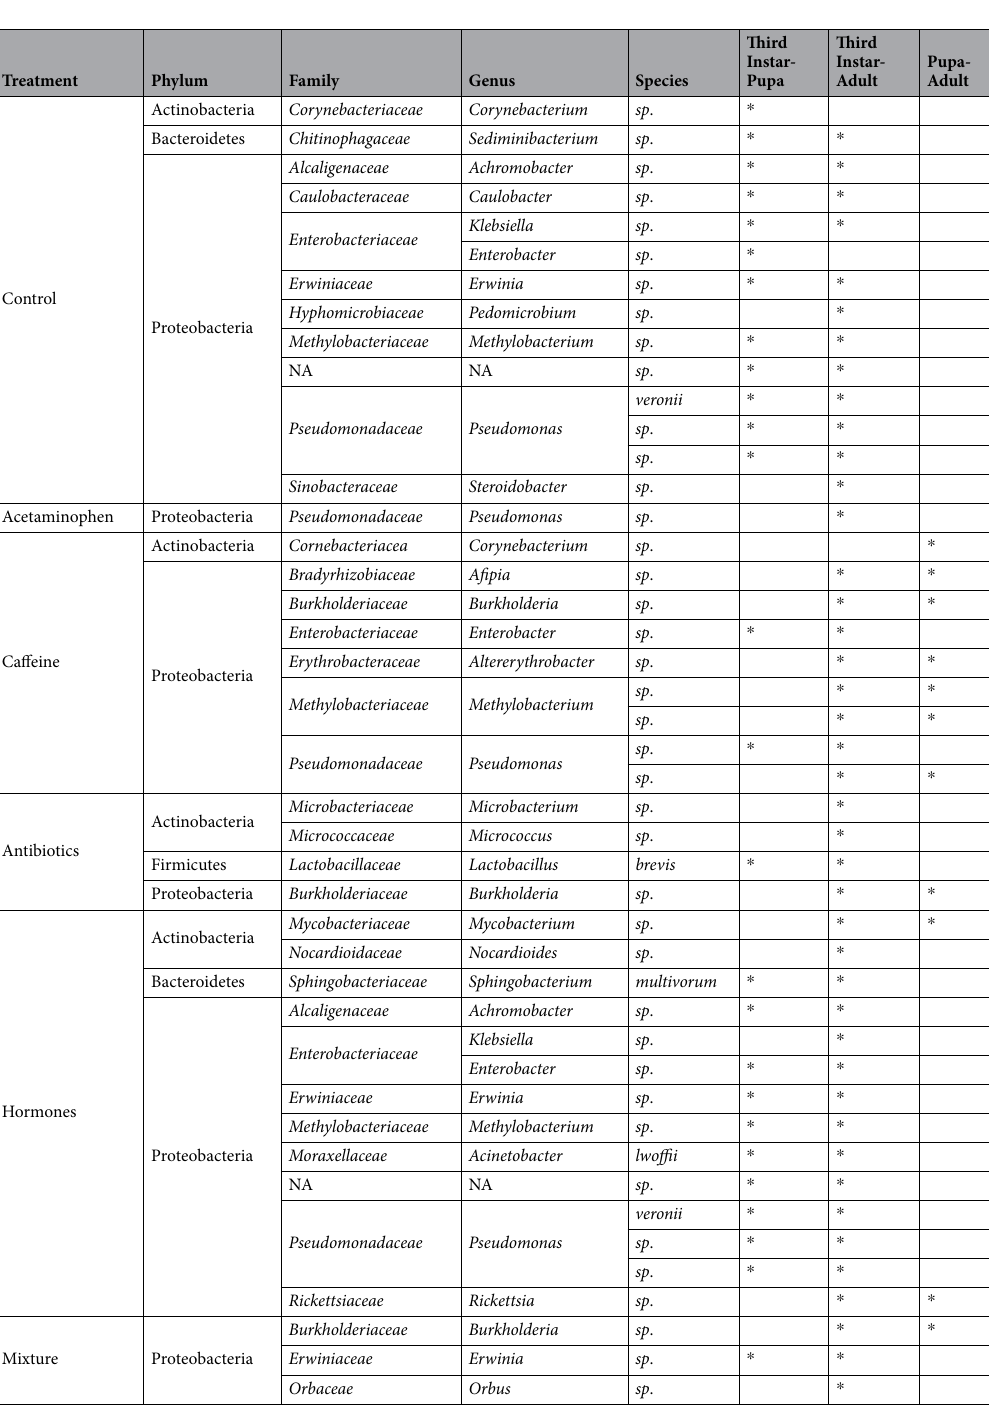
Table 1. Bacterial families and genera in each treatment that are significantly different in at least one life-stage pairing. * Denotes adjusted p value of < 0.05 in those genera for each life-stage pairing in a